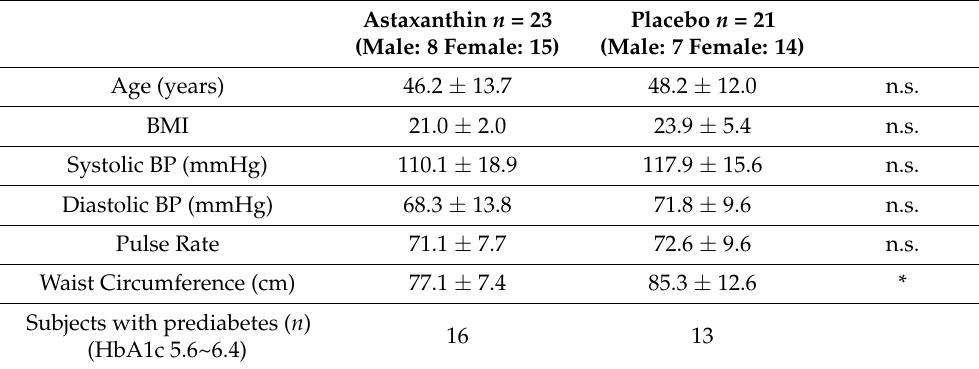
Table 1. Baseline characteristics of the participants.